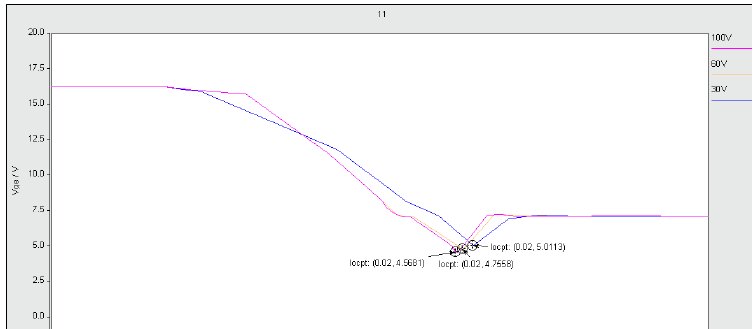
Figure 11. V ge comparison diagram under different U ZS 1 values.